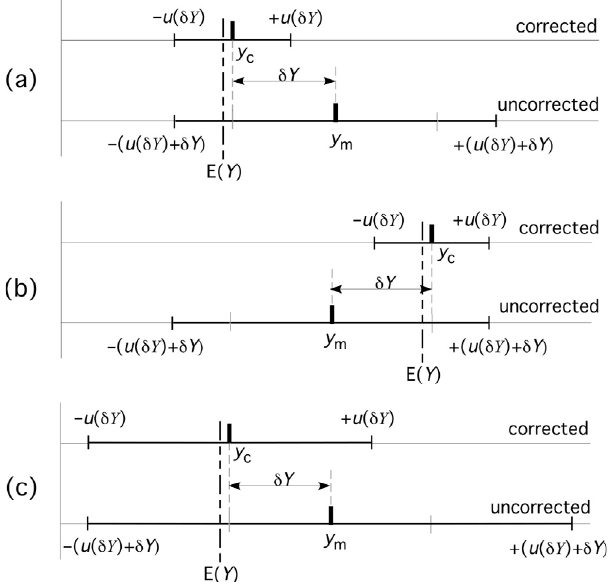
Fig. 1. Correction/no-correction process and outcomes: E ( Y ) = aimed Y value; y c = value after application of the estimated correction δY ≈ Δ to the measured value y m ; u ( δY ) = uncertainty of estimated correction δY . It can be y c − y m > u ( δY